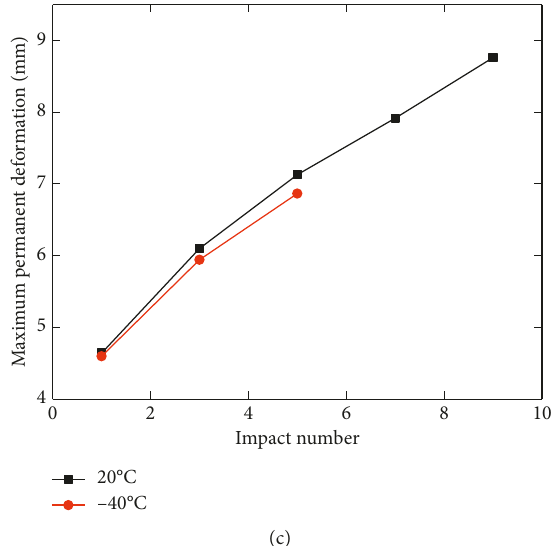
Figure 14: Maximum lateral plastic deformation at different temperatures. (a) L / D � 1/3. (b) L / D � 1. (c) L / D �